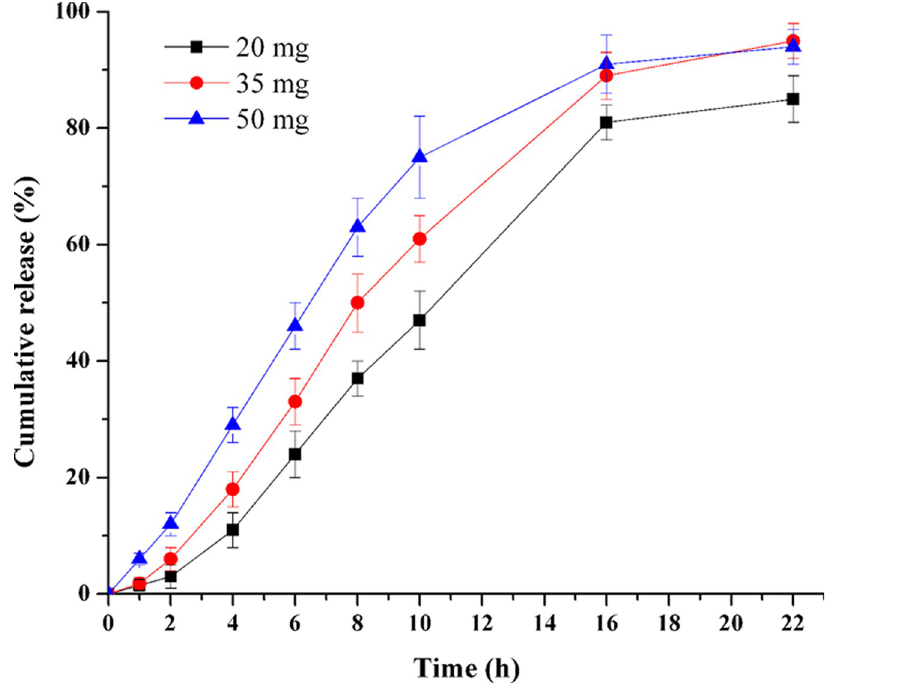
Fig 8. Effect of NaCl amount in push layer on TPM release (n = 6).